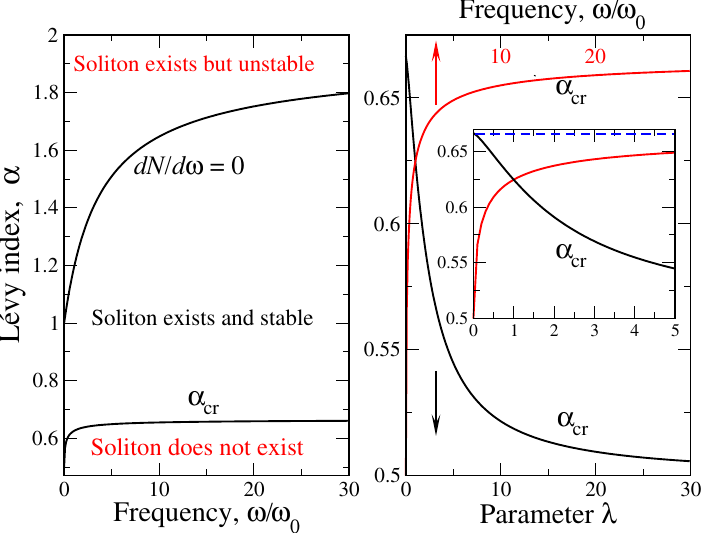
Figure 3. The ”phase diagram” of the soliton under consideration. Left panel shows the boundaries of soliton 0 versus dimensionless frequency ω/ω 0 . The intervals of existence ( 1 / 2 < α cr < 2 / 3 ) and stability dN / d ω = soliton existence and stability are shown in the panel. Right panel reports the soliton existence boundary α cr (ω/ω 0 ) − 1 / 2 (black curve) or ω/ω 0 (red curve). Inset in right panel reports the as a function of parameters (cid:31) = 0 (or ω 0 0 ) asymptotics details of α cr (ω/ω 0 ) at small ω . Dashed line in the inset corresponds to the g → → 2 / 3 , corresponding to the case of pure quintic nonlinearity) of soliton existence. ( α cr =